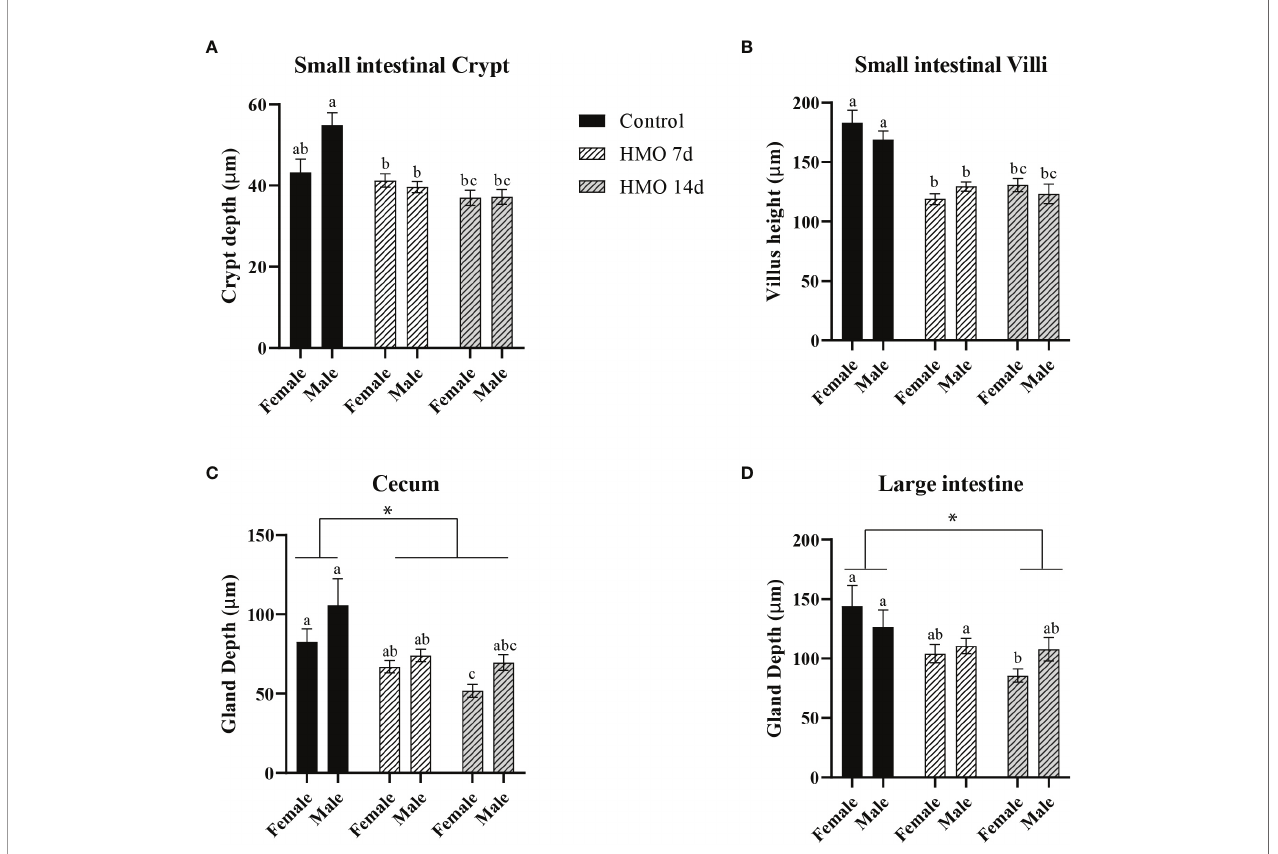
FIGURE 3 | Histomorphometric parameters analyzed in the control groups (n=5; M = 3, F = 2) and in the mice that received HMOs either for 7 days (n=18; M = 11, F = 7) or for 14 days (n=11; M = 8, F = 3) and euthanized at 50 days of age, respectively. (A) SI crypt depth (µm). (B) SI villus height (µm). (C) Cecal gland depth (µm). (D) Large intestinal gland depth (µm). a,b,c Different superscripts represent the statistical difference between individual groups. *Represents the statistical difference between groups regardless of